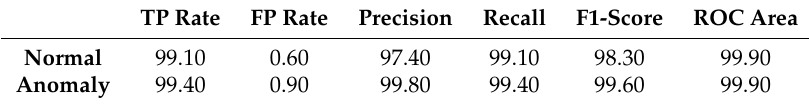
Table 12. Classification report for the Adaboost Random Forest.